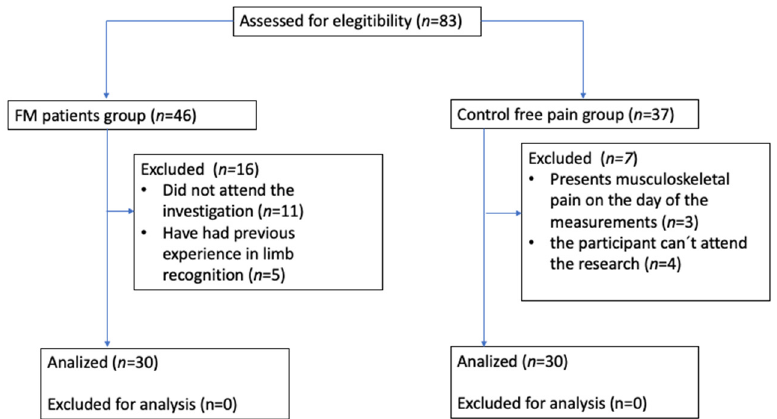
Figure 1. Study design. The following flowchart shows how the participants were distributed in the FMS study and control groups. The cases that were discarded because they did not meet the selection criteria or abandoned the investigation are shown.